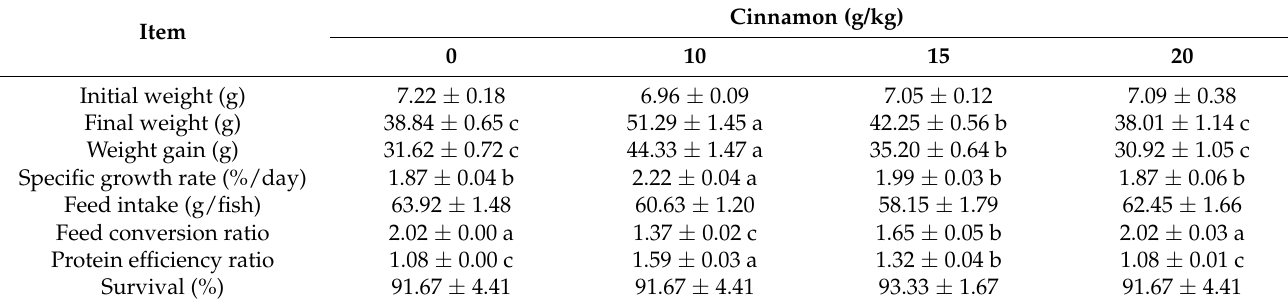
Table 2. Growth performance of European sea bass fed dietary cinnamon.